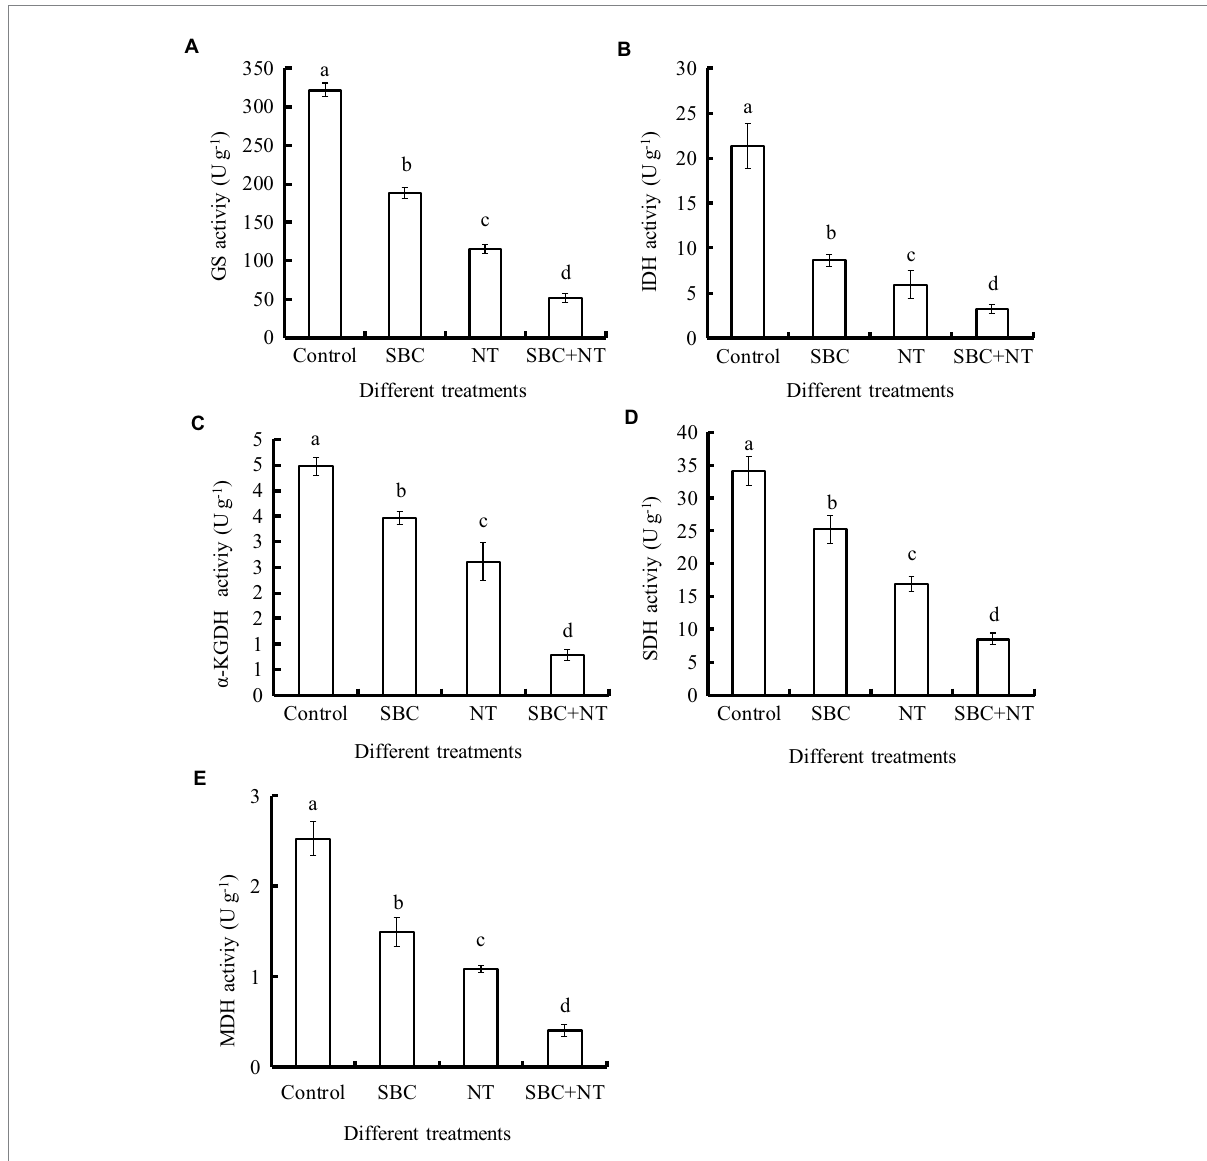
FIGURE 12 Effect of SBC, NT, and combined SBC and NT on enzyme activities involved in the TCA cycle. (A) GS activity; (B) IDH activity; (C) a-KGDH activity; (D) SDH activity; (E) MDH activity. ANOVA was employed to compare the mean values of analysis parameters ( p < 0.05). The results are shown as the mean ± standard deviation ( n = 3). Different superscript letters in the same column indicate significant differences ( p <